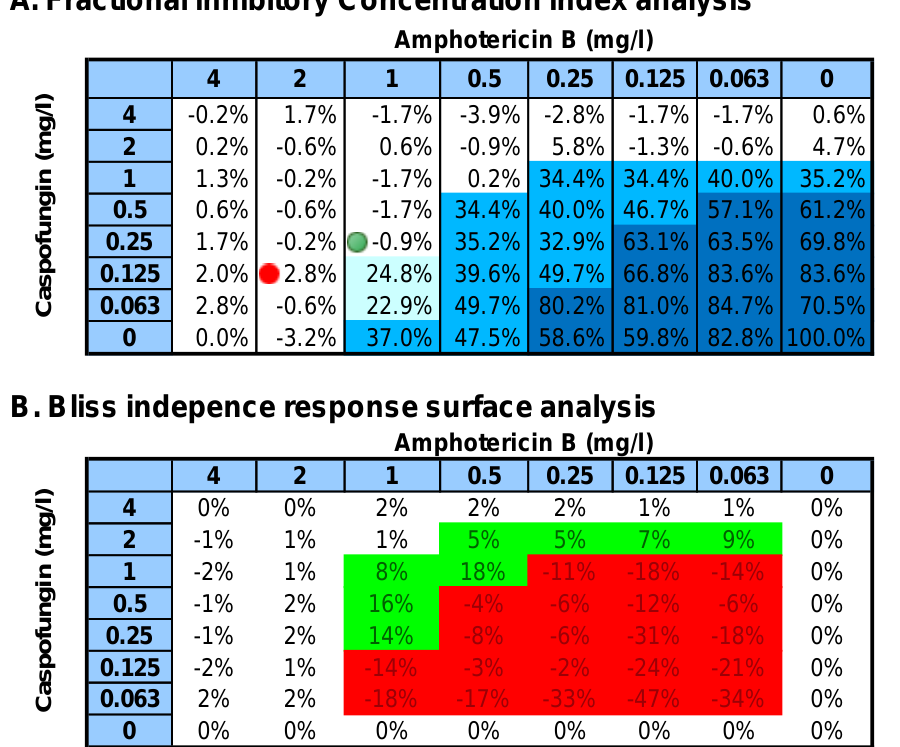
8 of 12 Table 4. Chi square analysis of the FIC index and BIRS analysis. Loewe Additivity